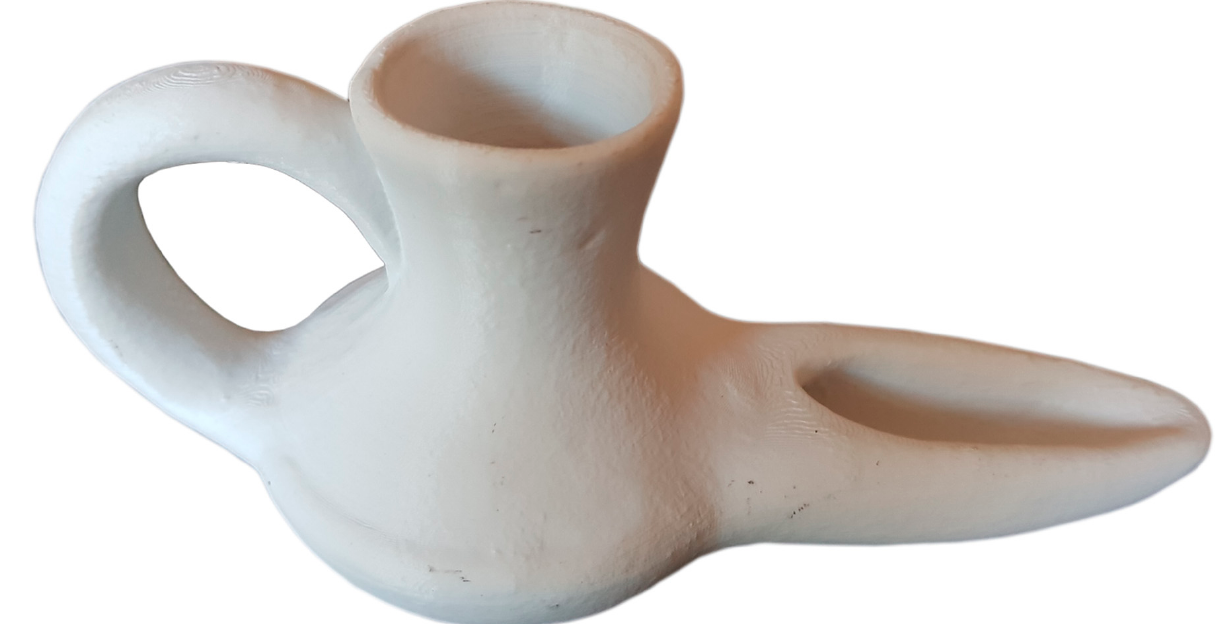
Figure 17. ( a ) Results showing that 7.828% dots have a larger difference than 0.4 mm ( b ) Results showing that 0.571% of the points have a smaller difference than − 0.4 mm. (Source: self-made).